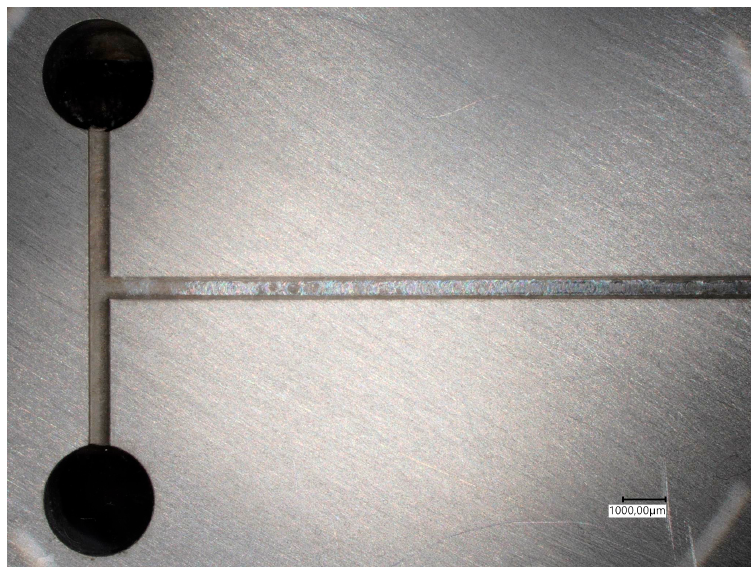
Figure 1. Top down view of the aluminium T-junction microchannel with two inlet and one output channels; square cross section of 500 × 500 µ m, hydraulic diameter of 500 µ m and 70 mm channel length (acquired with Keyence VHX-7000, Neu-Isenburg, Germany).